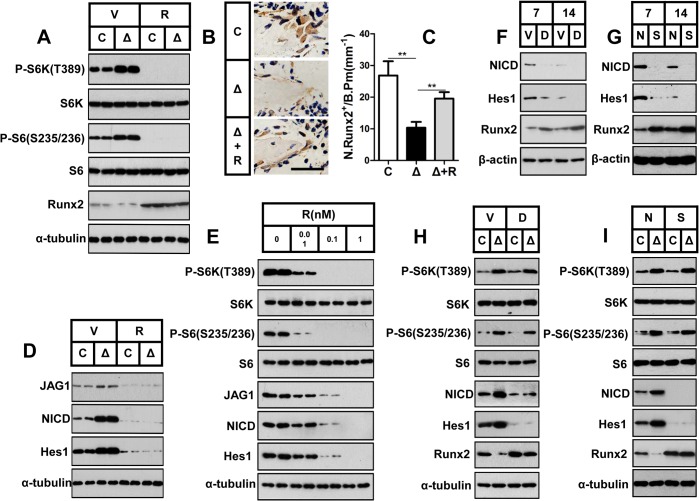
mTORC1 inhibits Runx2 expression by activating Notch signaling in preosteoblasts.(A) Control (C) and ΔTsc1 (Δ) primary calvarial cells were treated with vehicle (V) or 0.1 nM rapamycin (R) for 24 hours and then underwent immunoblotting to detect Runx2. (B) Immunohistochemical staining of Runx2 in sections of distal femur from 10-week-old control (C), ΔTsc1 (Δ) and rapamycin treated ΔTsc1 (Δ+R) mice. Scale bar, 50μm. (C) Number of Runx2 positive cells per bone perimeter (mm-1) (N.Runx2+/B.Pm).** P < 0.01 by t test. (D) Deletion of Tsc1 caused elevated expression of Jagged1, NICD and Hes1, while treatment with 0.1 nM rapamycin for 24 hours led to decreases in these parameters in primary calvarial cells. (E) Rapamycin dose-dependently reduced the expression of Jagged1, NICD and Hes1 in MC3T3-E1 cells. Differentiating MC3T3-E1 (F, G) and primary cavarial cells from control and ΔTsc1 mice (H, I) were treated with 50 μM DAPT (F, H) or Notch1 siRNA (G, I) and then underwent immunoblotting to detect Runx2. V: vehicle; D: DAPT; N: negative control; S: si-Notch1.